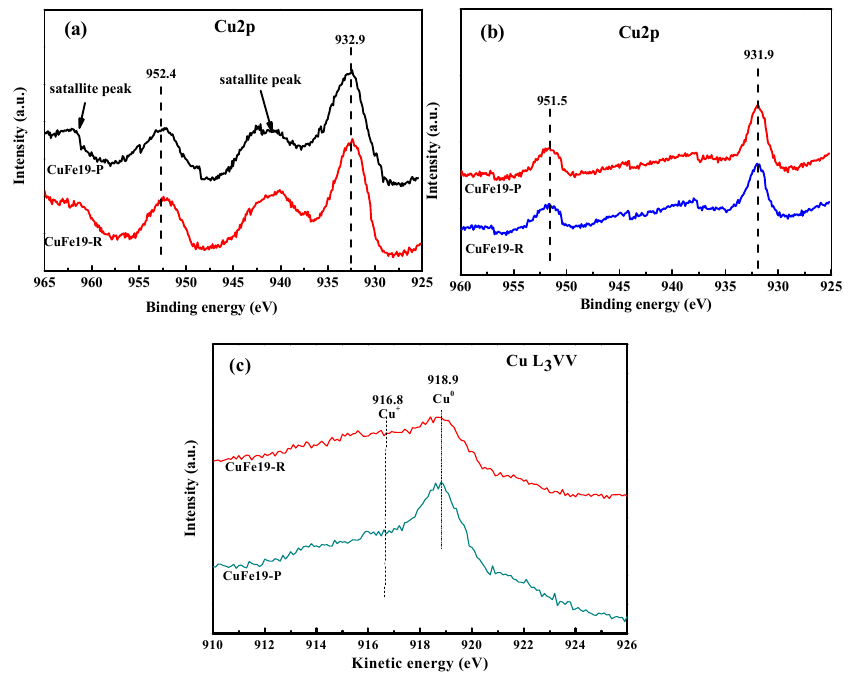
Figure 7. In ‐ situ XPS profiles of CuFe19 ‐ P and CuFe19 ‐ R, ( a ): Cu2p profiles of fresh samples; ( b ): Cu Figure 7. In-situ XPS profiles of CuFe19-P and CuFe19-R, ( a ): Cu2p profiles of fresh samples; ( b ): Cu 2p 2p profiles of reduced samples; ( c ): CuL 3 VV profiles of reduced samples. profiles of reduced samples; ( c ): CuL 3 VV profiles of reduced